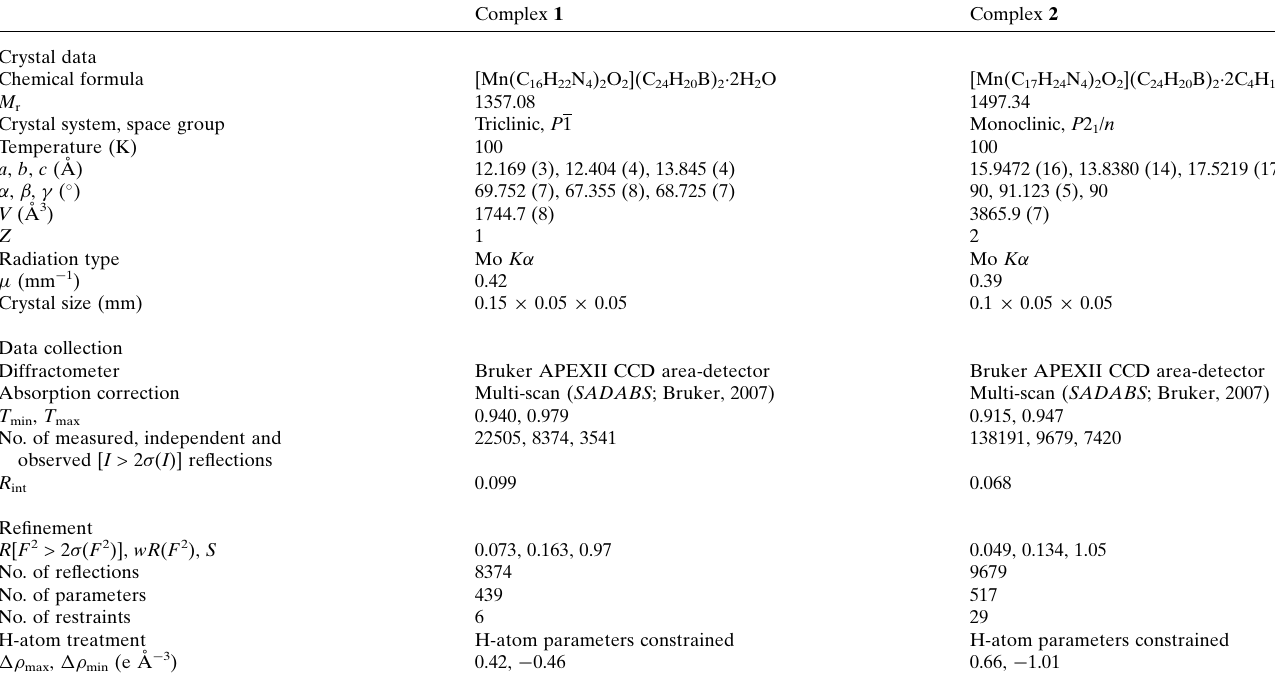
Complex 1 Complex 2